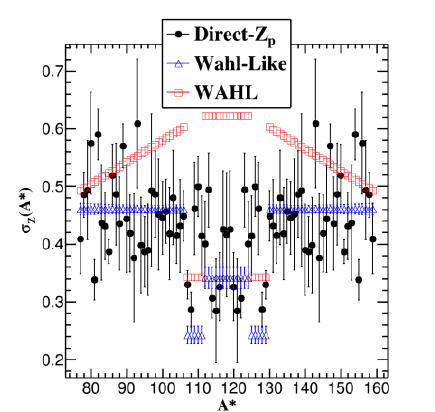
Fig. 5. Parameterization of  Z (A*) based on Wahl’s systematics (in red), Wahl-like approach with uncertainties (in blue) and direct-Z p approach (in black).